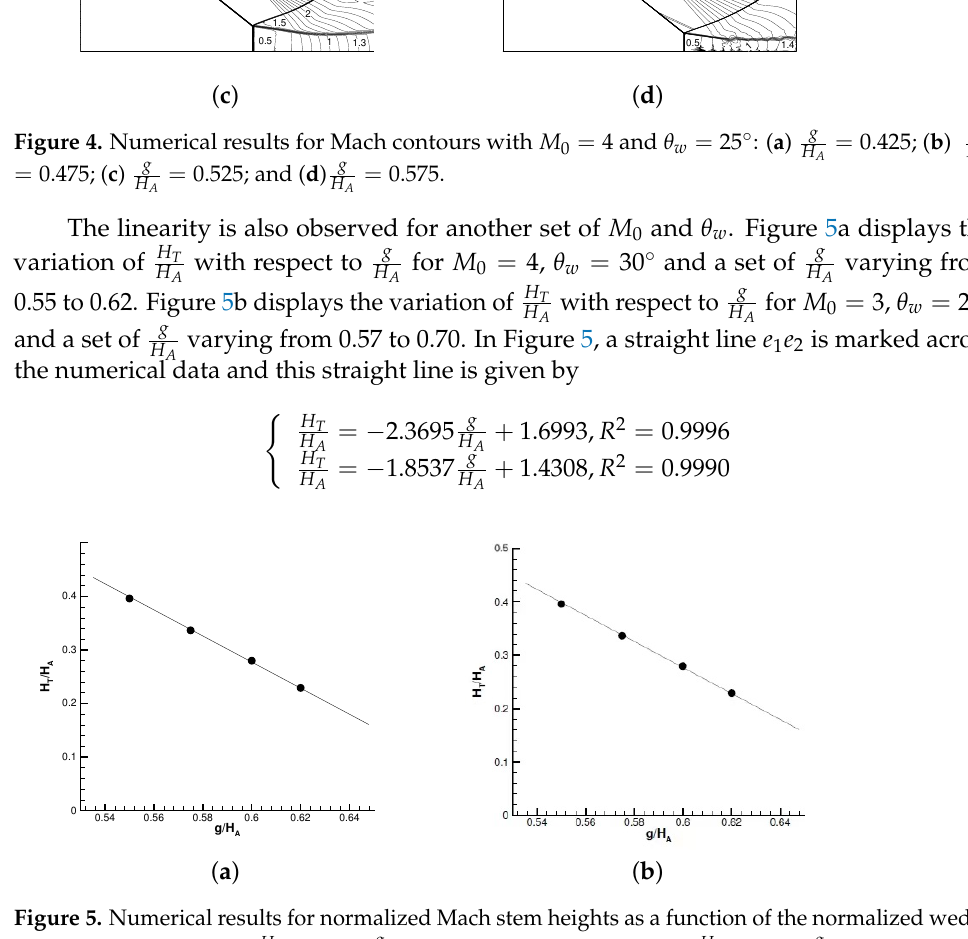
versus g for M 0 = 4 and θ w = 30 ◦ ; ( b ) H T H A H A